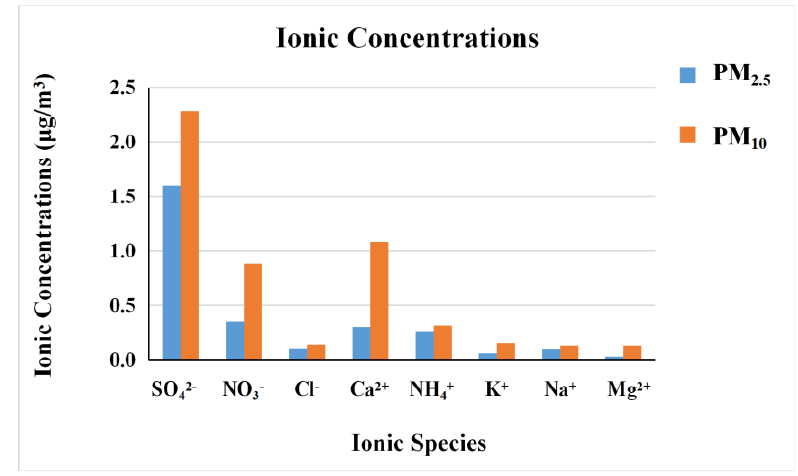
Figure 4. Mass concentrations of cation and anion in PM 10 and PM 2.5.